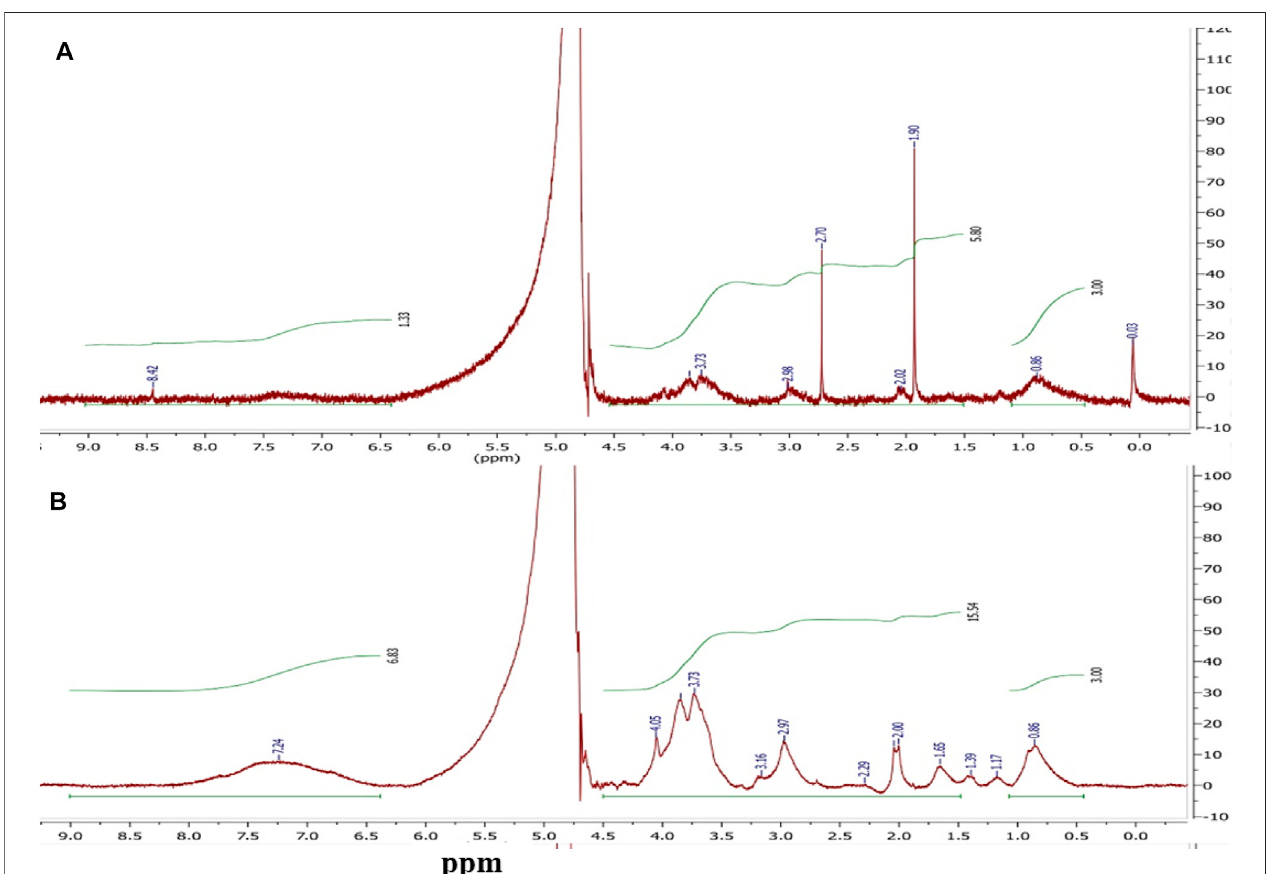
FIGURE 1 | 1 H-NMR (D 2 O, 500 MHz) spectra of (A) Lf and (B) MTX – Lf conjugate F3